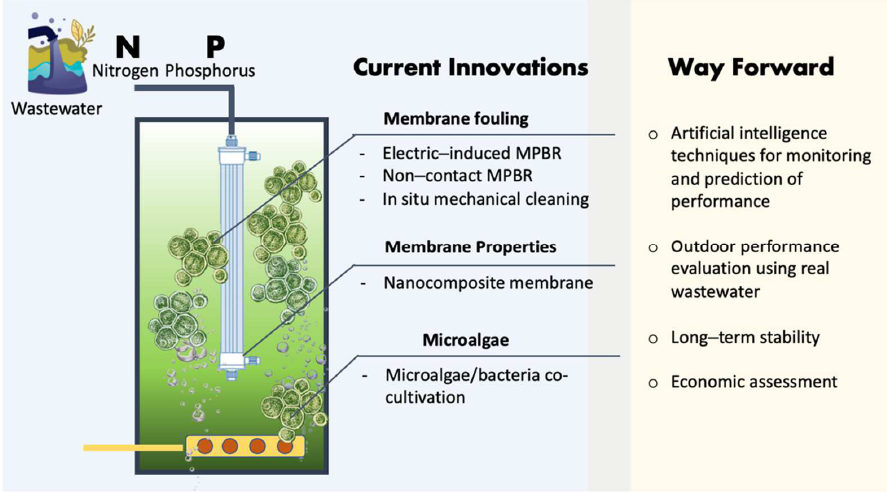
Figure 5. Summary of current innovations and the way forward for the implementation of MPBRs in wastewater treatment and nutrient recovery applications. Table 1. Summary of the nutrient removal efficiencies of MPBRs.